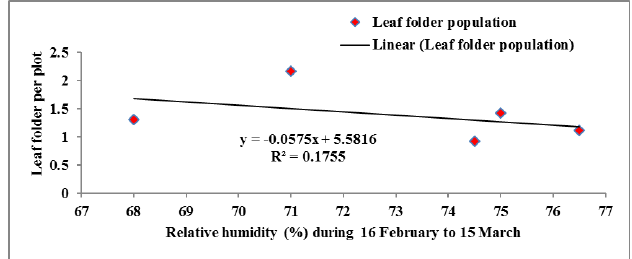
Figure 2: Relationship between the population of leaf folder and humidity There was a negative correlation (R 2 = -0.317) between the population of gram pod borer and temperature. It indicates that the population of gram pod borer was decreased with increasing temperature. A linear regression was fitted between temperature and population of gram pod borer (Figure 3). The regression equation y = a + bx, where y = population of gram pod borer, a = 7.074, b = -0.197 and x = temperature. The contribution of the regression (R² = 0.317) was 31.7%.